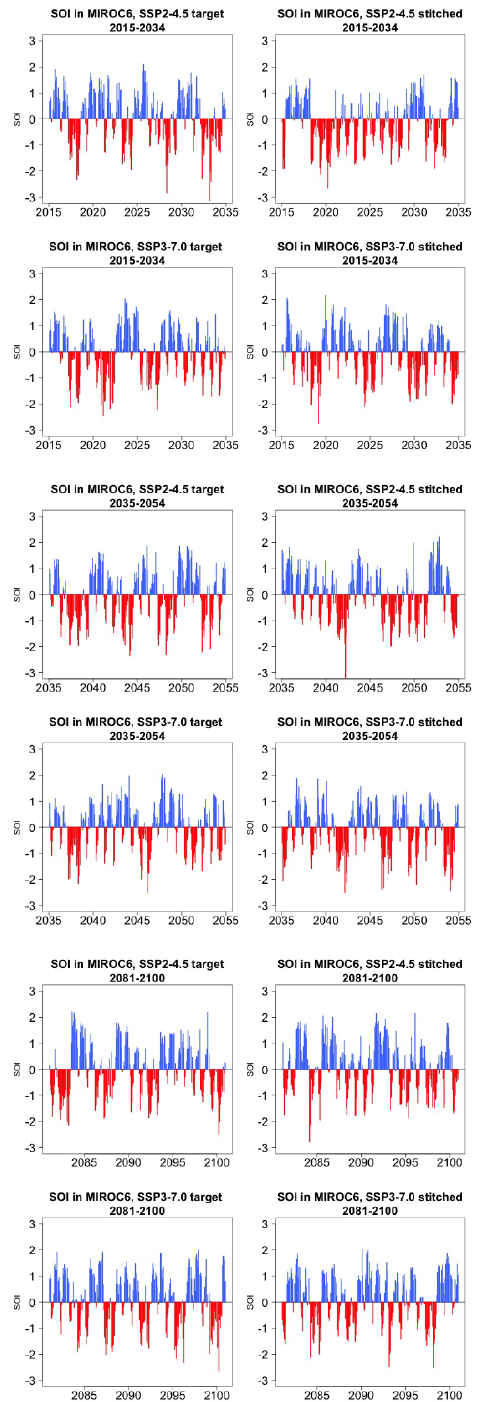
Figure D1. Examples of target (left) and stitched (right) SOI time series for three 20-year windows along the length of the simulation: 2015–2034 in the top four panels, 2035–2054 in the middle four panels, 2081–2100 in the bottom four panels. Results from emulation of SSP2-4.5 and SSP3-7.0 for one of three ensemble members emulated under each scenario for MIROC6.